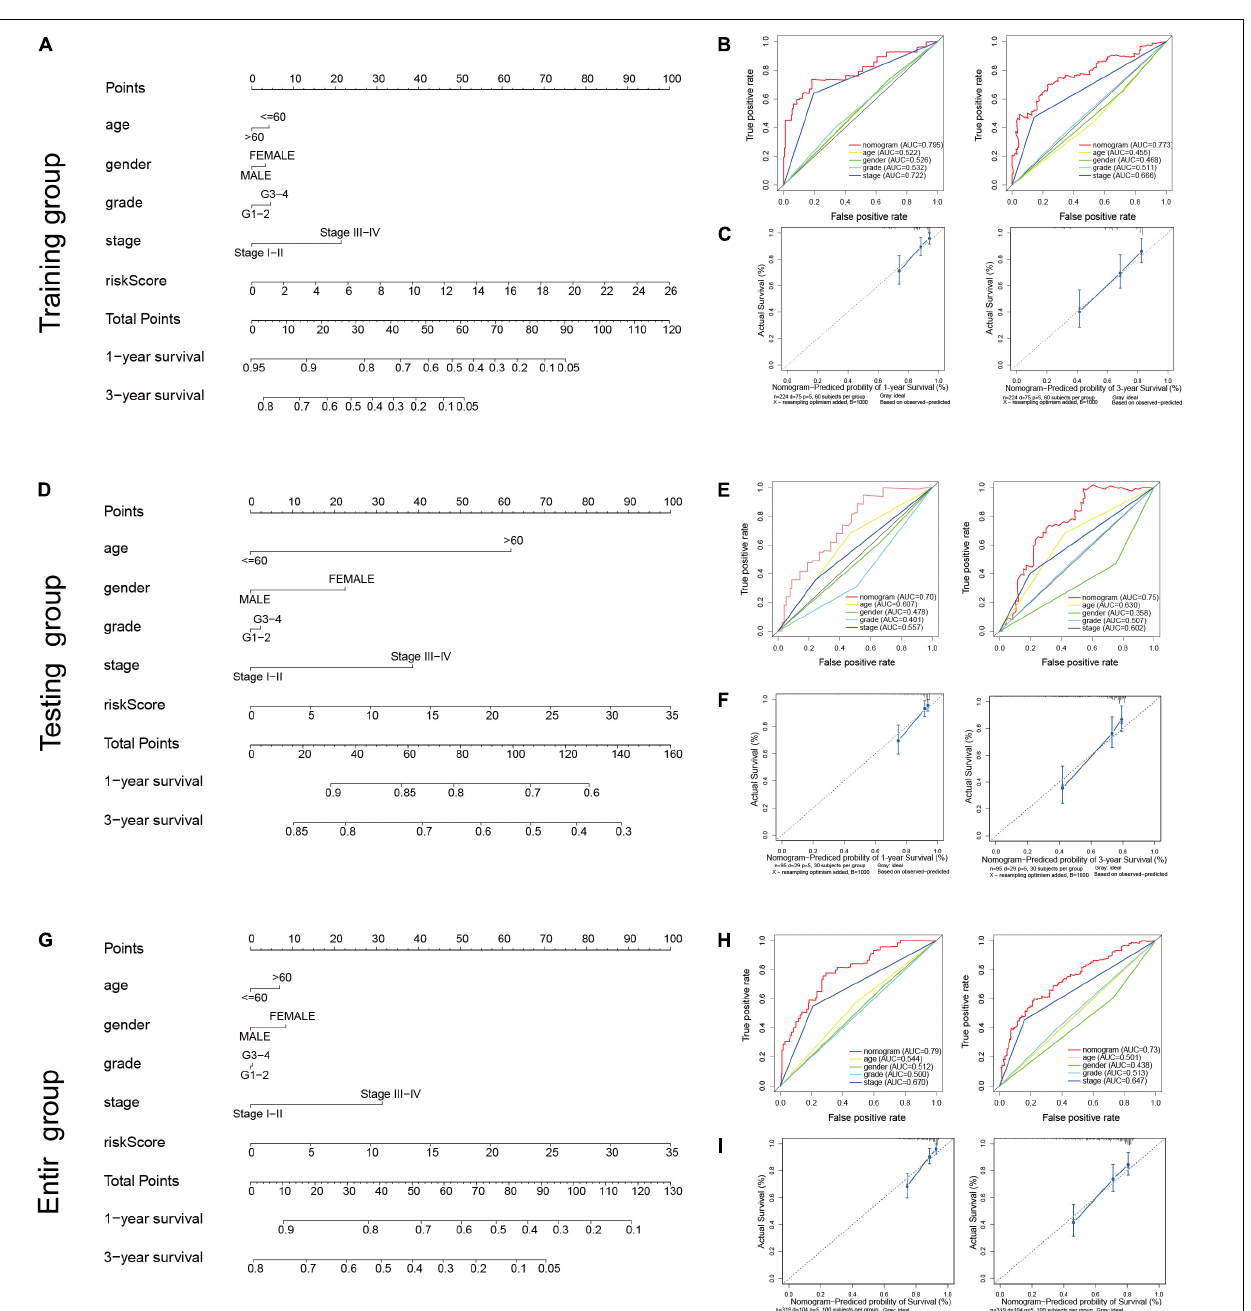
Frontiers in Medicine |